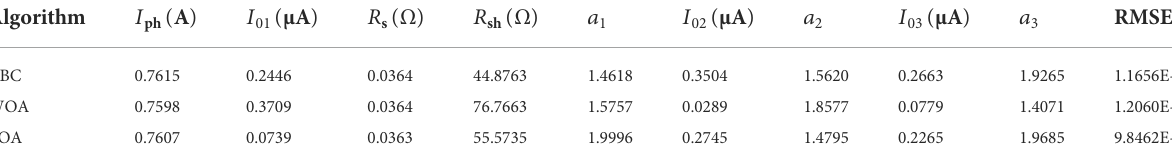
TABLE 3 Model parameters identi fi ed by various algorithms for TDM.